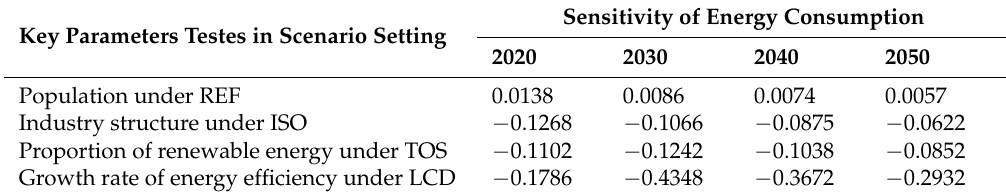
Table 4. The sensitivity analysis of energy